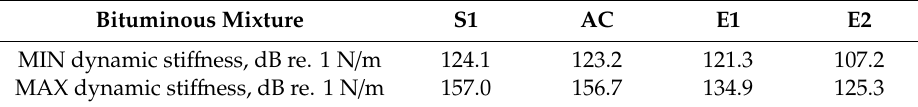
Table 3. The extreme dynamic sti ff ness values in the 10–1000 Hz band—the second stage. Bituminous